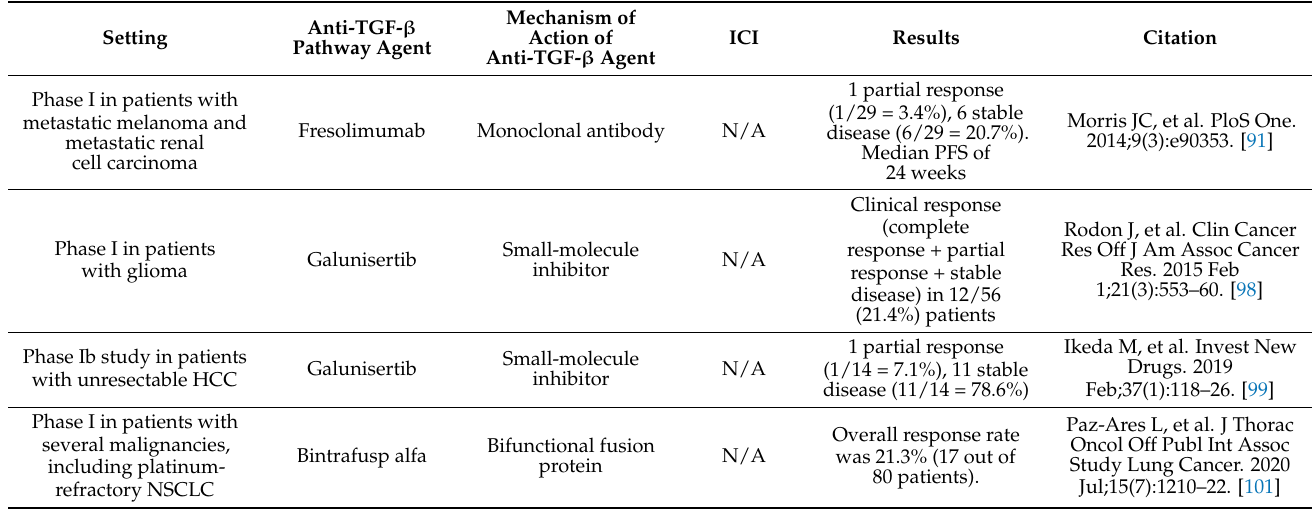
Table 1. Completed clinical trials involving anti-TGF- β pathway therapies with or without ICI in the setting of ad- vanced/metastatic UC or advanced solid